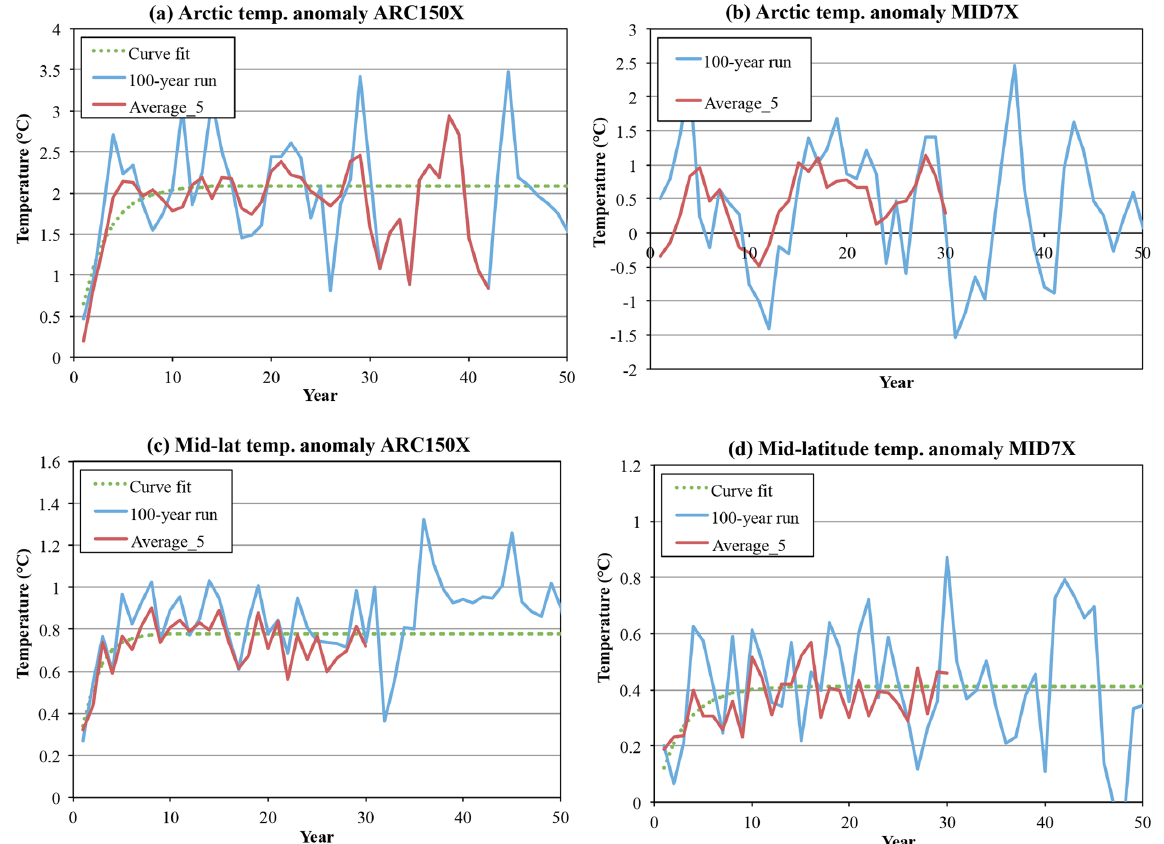
Figure 9. Time series of mean surface temperature response from ARC150X (a, c) and MID7X (b, d) BC emission perturbations as compared to PD. The response is shown over the Arctic (a, b) and midlatitudes (c, d) . Shown are the 100-year ensemble simulation (blue lines), the average of five 30-year ensemble members (red), and a numerical fit for an exponential approach to the long-term average (green dashed line). Curve fits used the package STAN in R, which is a Bayesian inference using the “No-U-Turn” sampler. Note that MID7X Arctic temperature response does not result in a fit due to